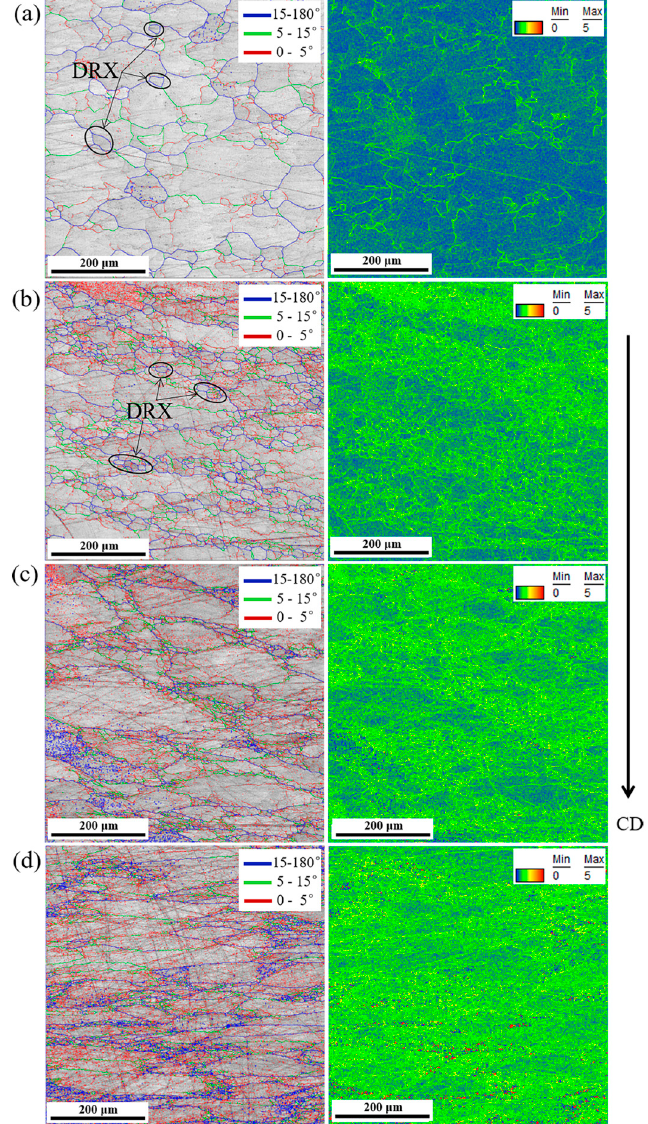
Figure 11. Grain boundary distribution and kernel average misorientation of Ti555211 samples at 950 °C in the case of the various strain rates: ( a ) 0.005 s − 1 ; ( b ) 0.05 s − 1 ; ( c ) 0.5 s − 1 ; ( d ) 5 s − 1 .